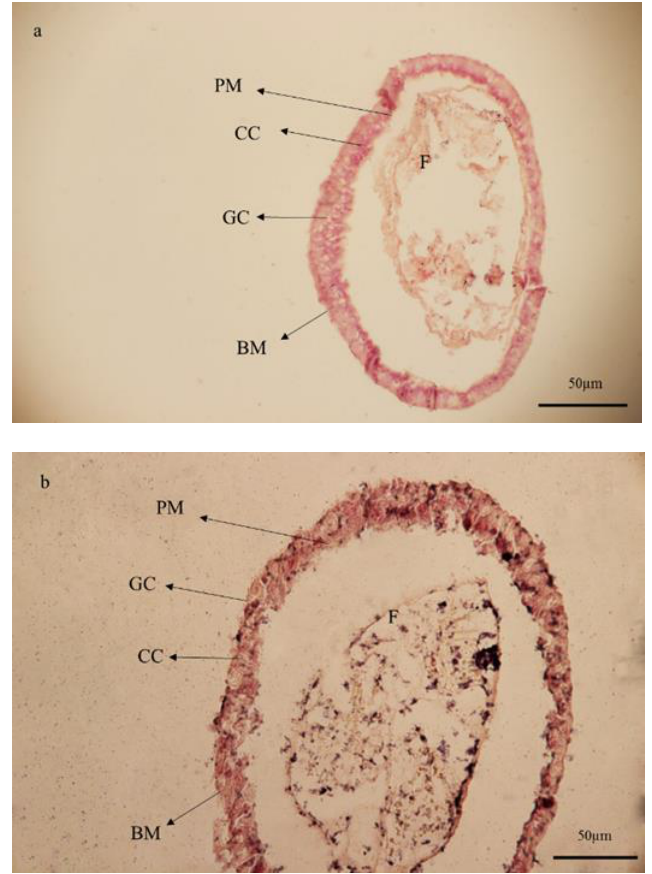
Figure 5. Light microscopy of the larval midgut of Glyphodes pyloalis in control ( a ) and after oral treatment with Artemisia annua floral essential oil ( b ). Normal texture of all cell types ( a ) was contrasted to changes in size and texture in treated larvae ( b ). In the midgut of insects treated with essential oil from A. annua the cohesion of the columnar epithelial layer was damaged. ( BM ) basement membrane, ( CC ) columnar cell, ( GC ) goblet cell, and ( PM ) peritrophic